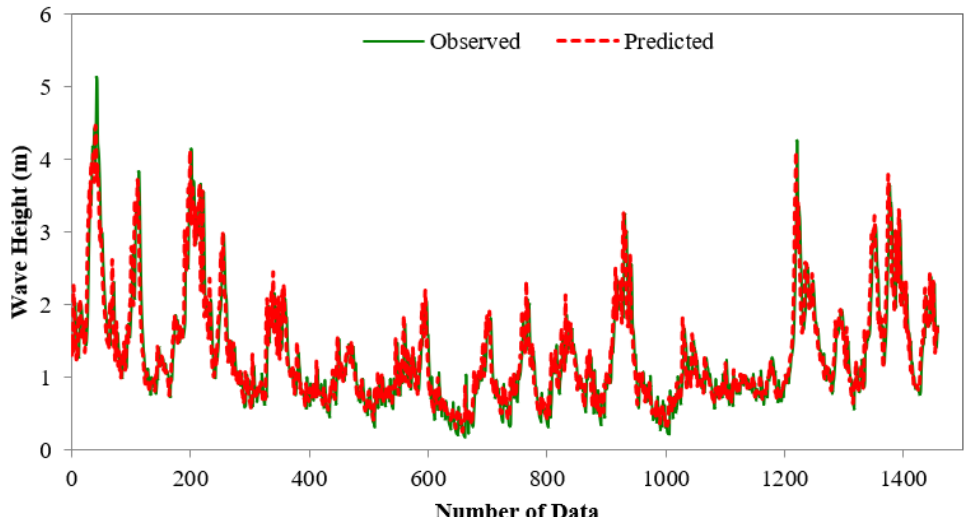
Figure 2. Comparison of ANN results and observed data of wave height for the training results.